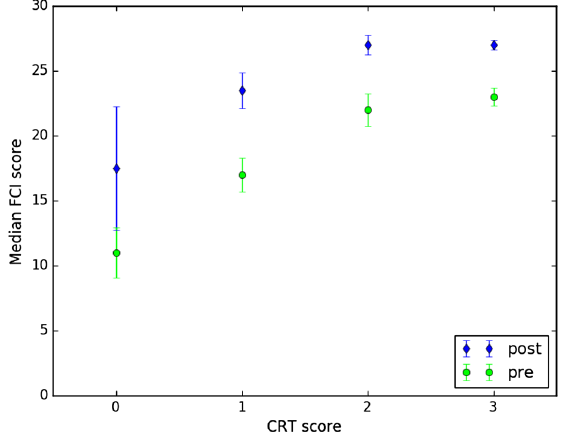
FIG. 1. Median FCI score versus CRT score for precourse and postcourse FCI tests. Uncertainties are standard error on the median calculated as described in Ref.